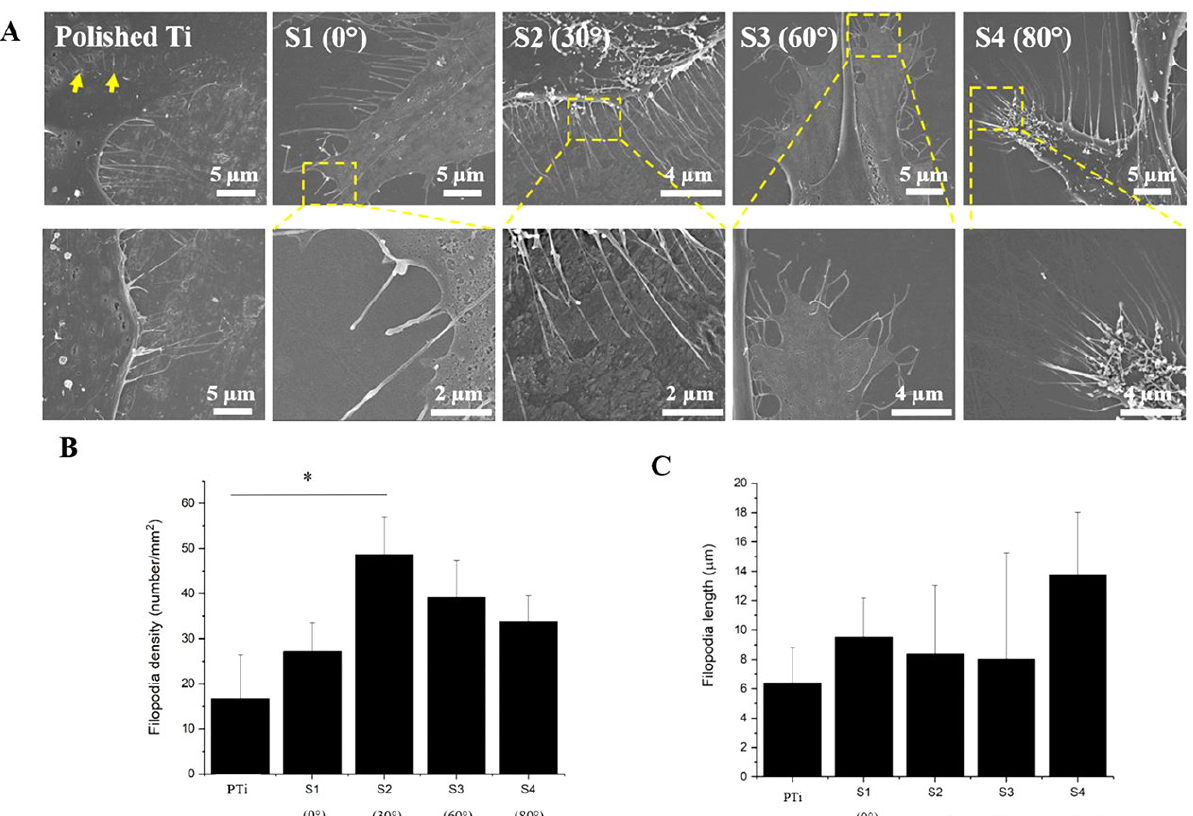
Figure 7. ( A ) SEM images of spread HASMCs on nanopatterned surfaces irradiated at different incident angles with corresponding zooms of the areas highlighted in yellow. ( B , C ) Results of the statistical analyses of ( B ) filopodia density and ( C ) filopodia length. The asterisk indicates a significant difference ( p < 0.05). Reprinted with permission from Ref. [93]. Copyright 2019 American Chemical Society.